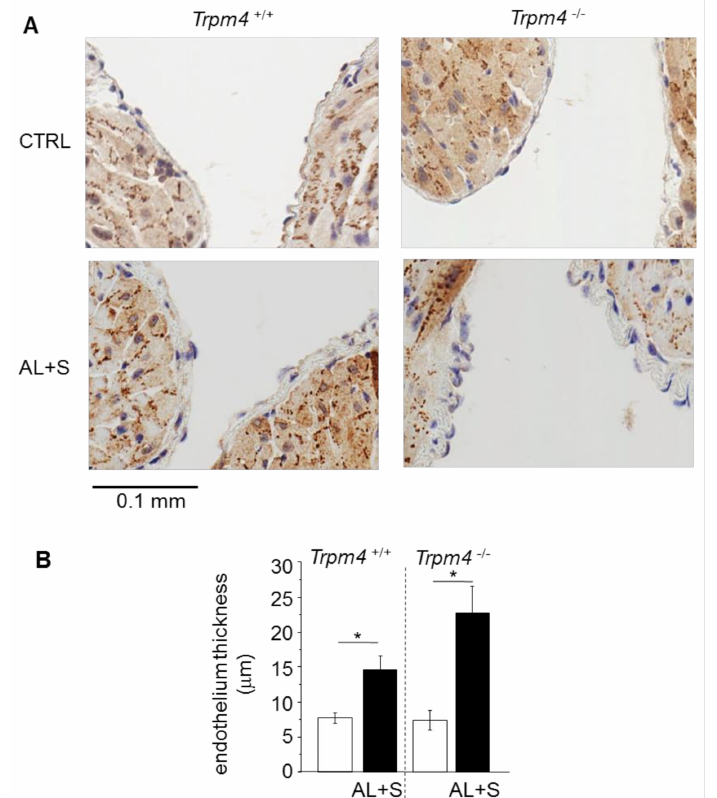
Figure 5. Endothelial enlargement. ( A ) Representative sections (6 µ m thickness) of the left atrium showing the endothelium from Trpm4 +/+ and Trpm4 -/- animals after 28 days of treatment with or without aldosterone + salt. Hematoxylin labeling (nucleus in blue). Pictures are selected to show the inside of the atrium allowing to observe two sections of the endothelium of the same atrium; ( B ) mean endothelium thickness for each group ( n = 7 to 20; N = 2 to 6). Aldosterone treatment produces endothelial thickening in both Trpm4 +/+ and Trpm4 -/- animals. Statistical significance between groups are indicated by